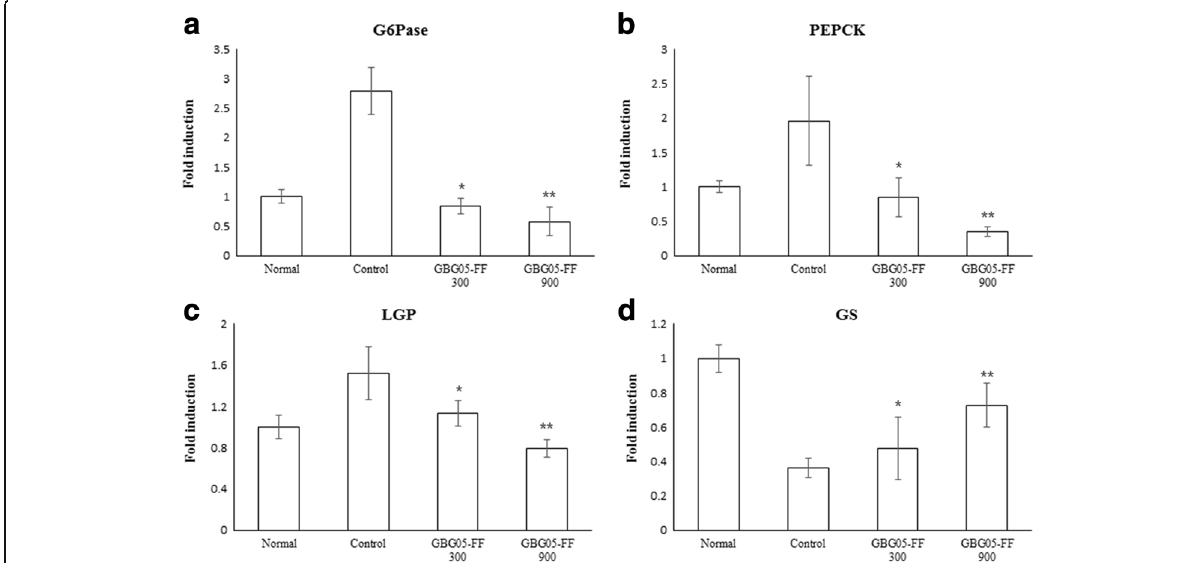
Fig. 7 Effects of GBG05-FF on the expression of G6Pase ( a ), PEPCK ( b ), LGP ( c ) and GS ( d ) in the liver of mice. Normal: dbh, Control: db/db, GBG05-FF 300: db/db fed the GBG05-FF 300 mg/kg, and GBG05-FF 900: db/db fed the GBG05-FF 900 mg/kg. Each value represents the mean ± SEM ( n = 10 per group) in three independent experiments. * P < 0.05, ** P < 0.01: Significant difference vs. control